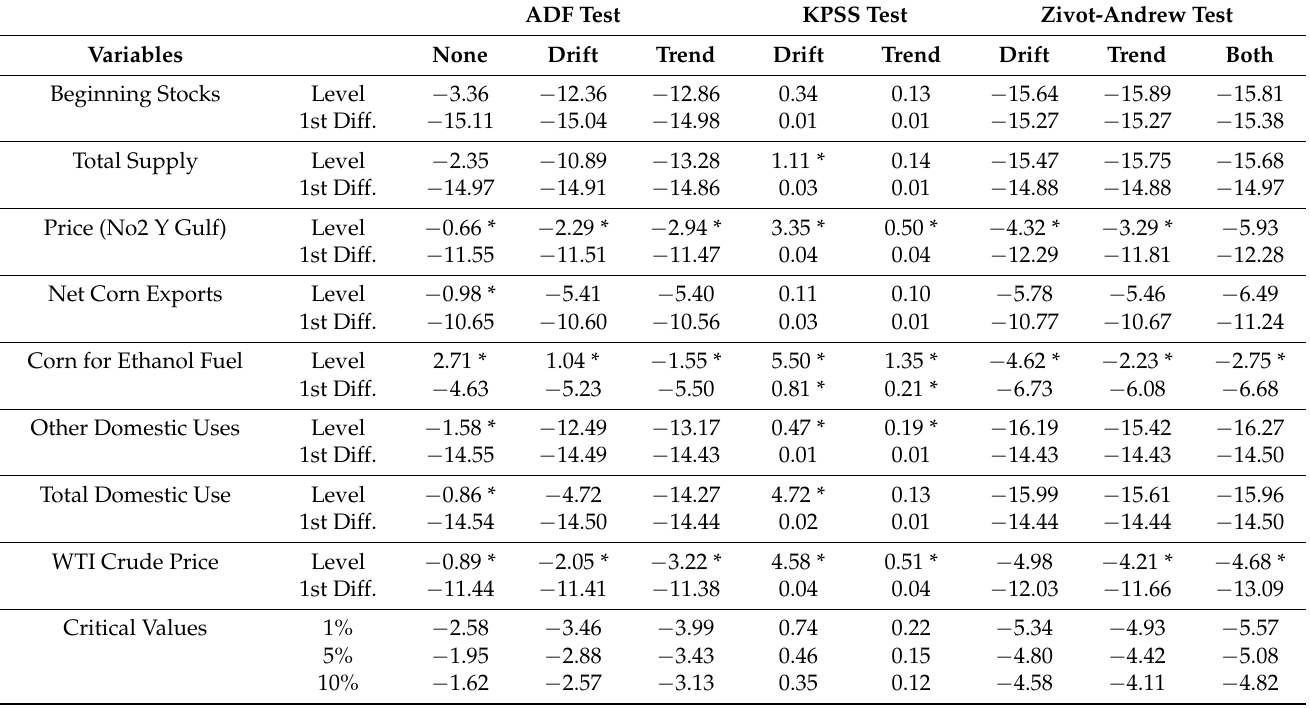
Table 1. Unit root test results for U.S. MY quarterly data ( * indicates unit root at 5% level). ADF